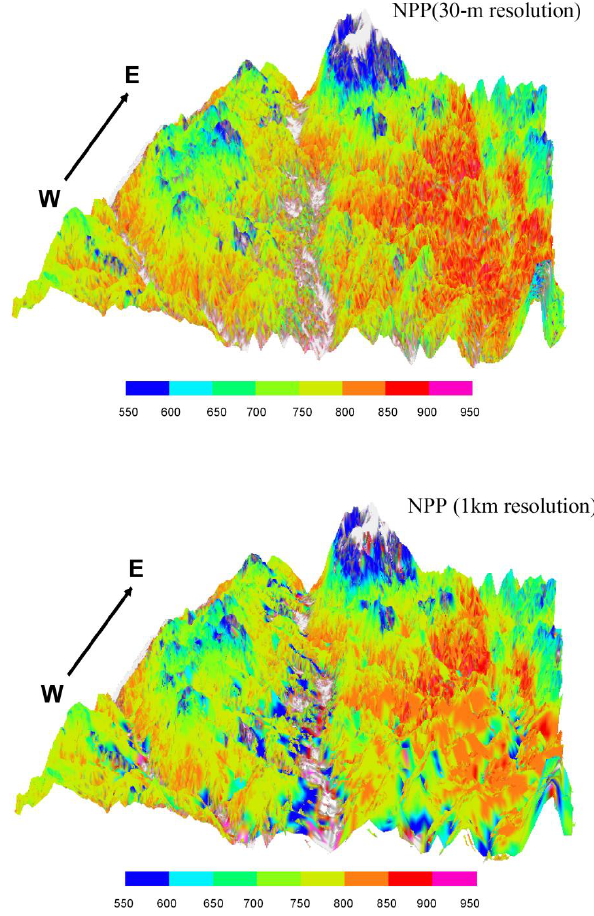
Fig. 6. Comparison of spatial distribution of NPP simulated at 30m resolution and 1km Figure 6. Comparison of spatial distribution of NPP simulated at 30 m resolution 5